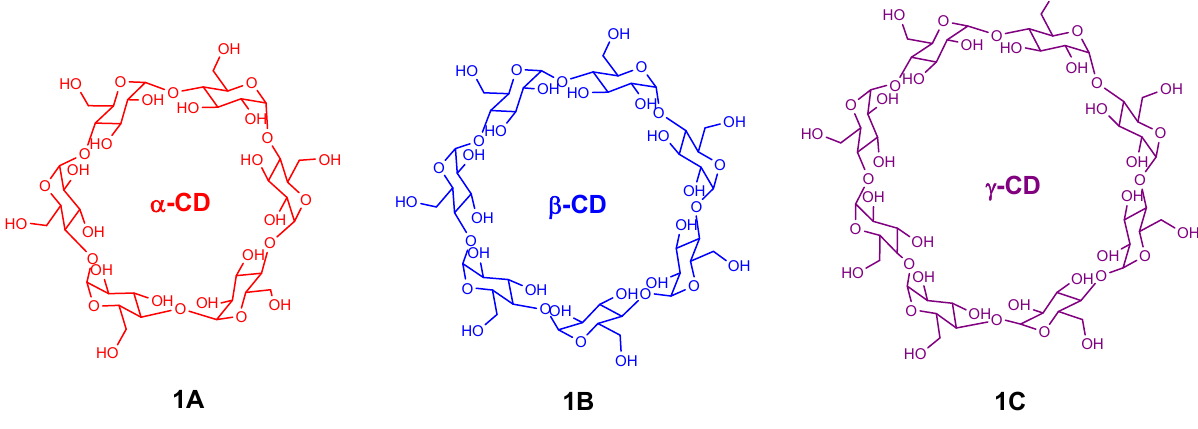
Figure 1. Structures of α -cyclodextrin ( 1A ), β -cyclodextrin ( 1B ) and γ -cyclodextrin ( 1C